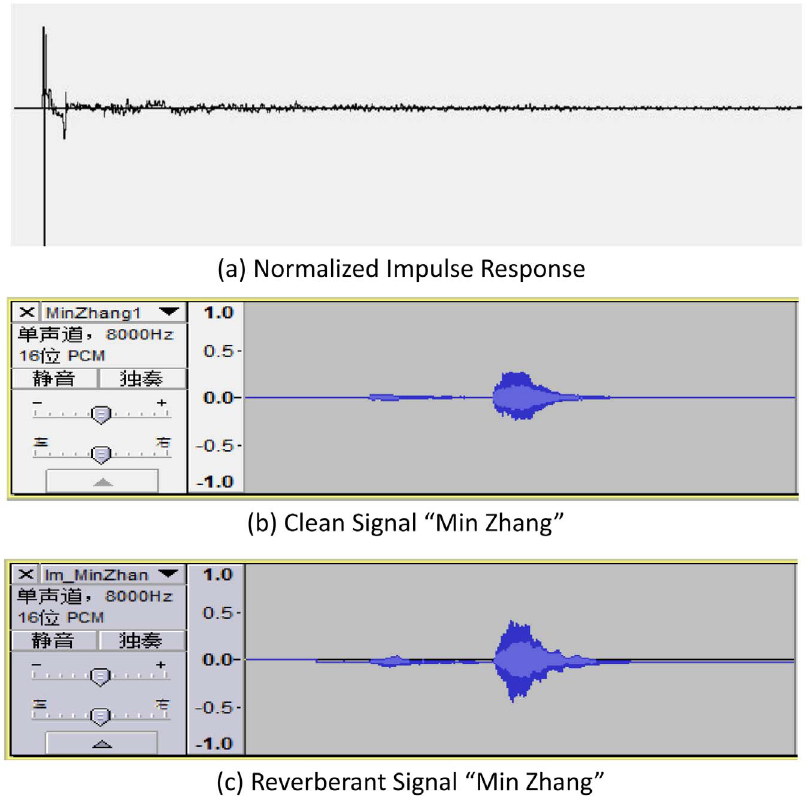
Figure 4. The samples of clean and reverberant signals of audio ‘‘MinZhang’’.